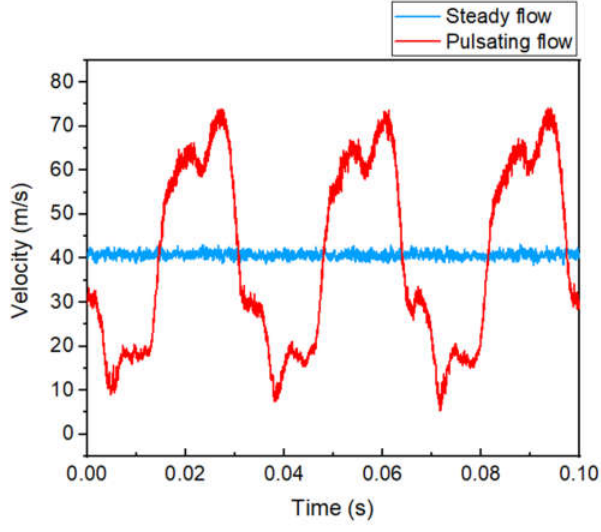
Figure 4. Instantaneous velocities at the “Inlet” section of the steady flow and pulsating flow.